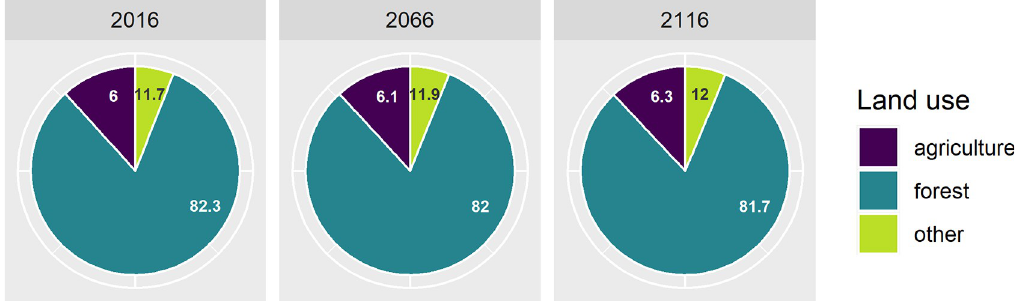
Fig 3. Percentages of different land uses in 2016, 2066, and